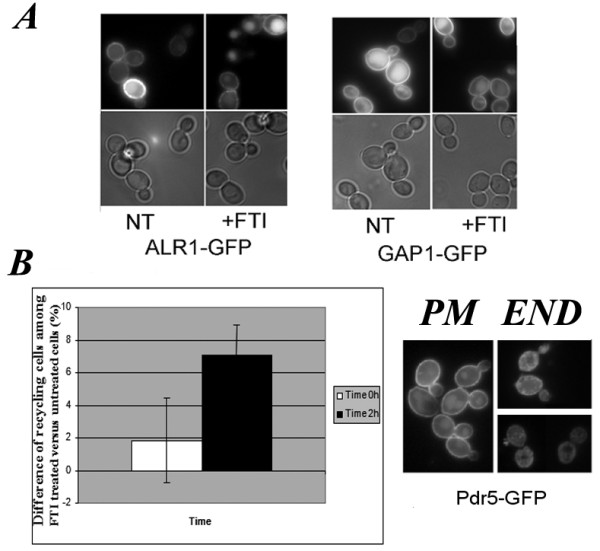
Multidrug transporter GFP-Pdr5 recycling is affected by FTI treatment of wt cells. A, fluorescence (upper panels) and DIC (lower panels) images of K699 cells expressing Alr1-GFP or Gap1-GFP proteins. B, Representative fluorescence images of cells expressing PDR5-GFP with plasma membrane (PM) or endosomal (END) localization are shown in the right panels. Images were taken in a blind fashion at time 0 h (T0) or 2 h (T2 h) after 10 μM FTase inhibitor addition and at least 100 cells were counted per sample. The graph on the left represents the increase (%) of END-type over PM-type cells observed in FTI-treated versus untreated cells. The values are the mean of 3 independent experiments. Bar indicates standard deviation. 10 μM FTase inhibitor I (+FTI); untreated (NT).